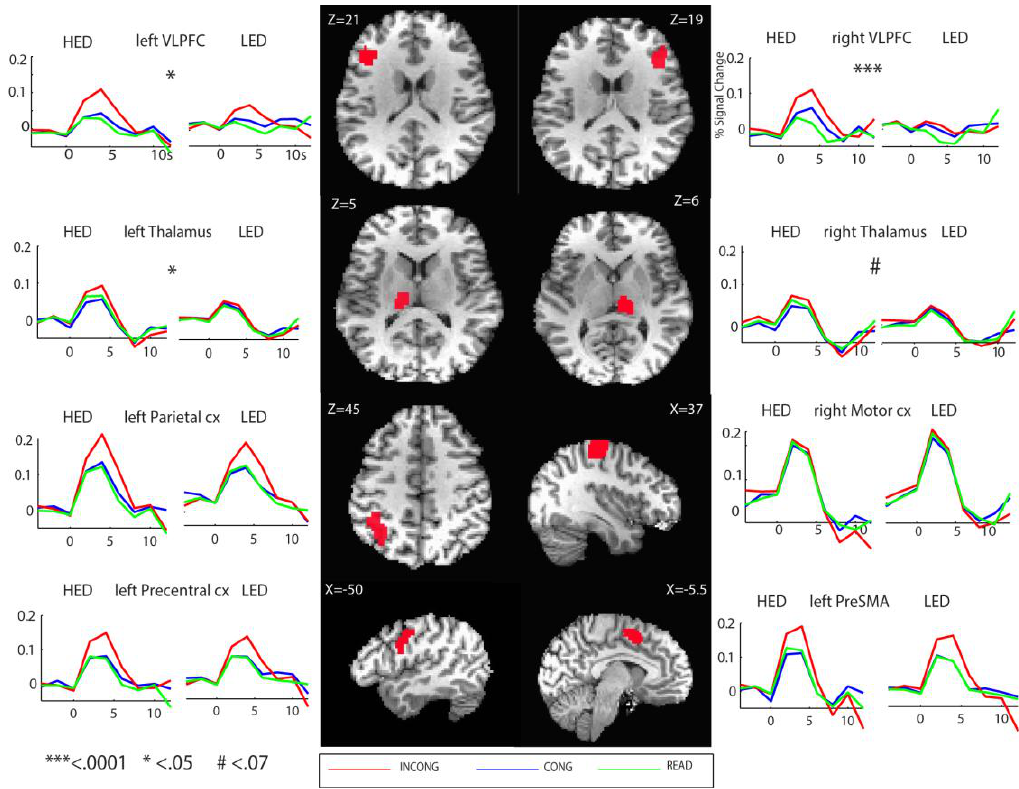
Figure 4. Group average time series expressed as % signal change of the blood oxygenated level dependent (BOLD) signal for the effects of Condition and Group. As shown in Table 2, greater BOLD contrast was observed in HEDs in ventrolateral prefrontal cortex (VLPFC) and the thalamus bilaterally. Response conflict evoked greater activity in the frontal and parietal association cortices overall, but only marginally in the thalamus and not in the sensorimotor cortex (*** <0.0001; * <0.05; # <0.07). Table 2. Statistical results for regions of interest (ROI) and their Talairach coordinates, trial condition effects, and INCONG vs. CONG & READ (INC > C + R) results for HEDs and LEDs. Area Tal. Coord